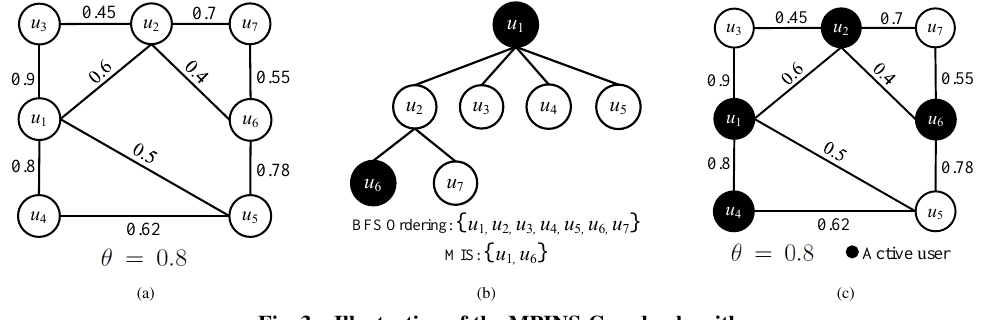
Fig. 3 Illustration of the MPINS-Greedy